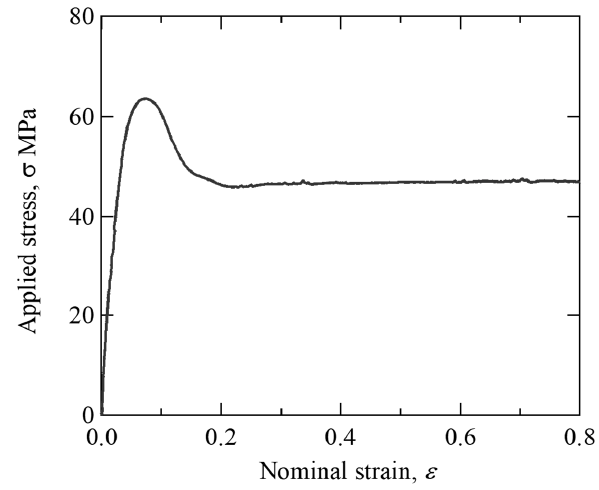
Figure 3. Relation between applied stress and nominal strain.